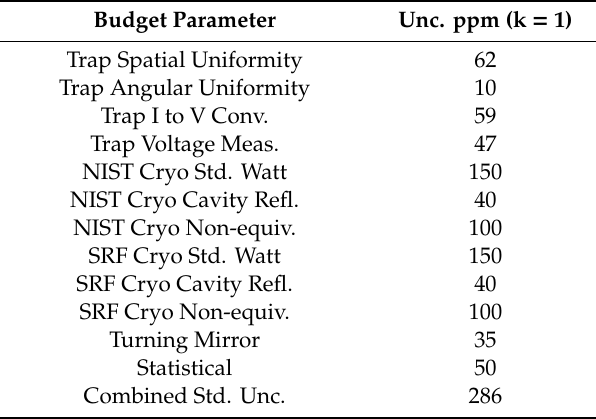
Table 4. Full trap transfer uncertainty budget.